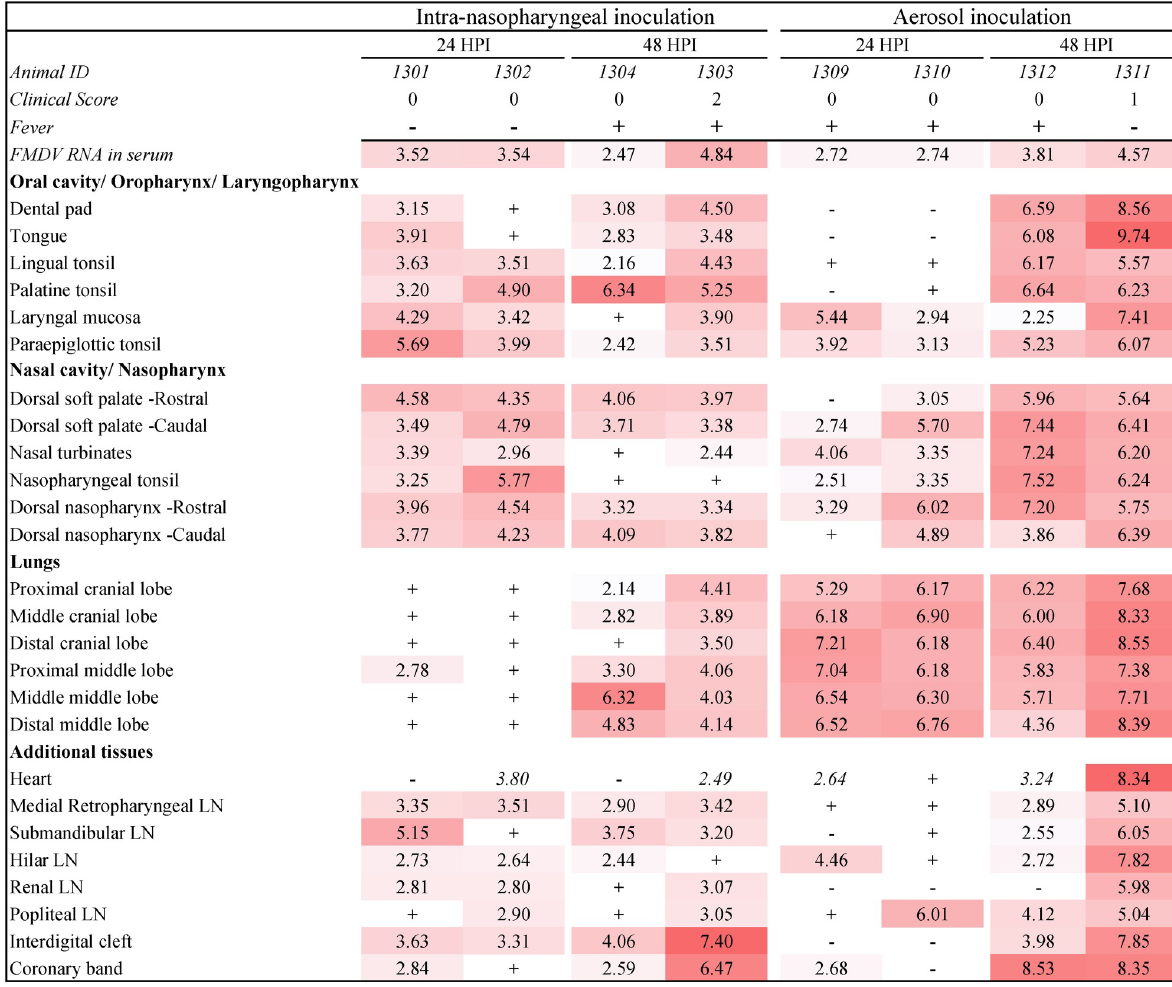
Fig 1. FMDV distribution in ovine tissues during early infection. FMDV detection in tissue samples obtained at 24 and 48 hours post intra- nasopharyngeal or aerosol inoculation. The clinical score represents the numbers of vesicular lesions detected at the time of euthanasia. Numbers in the table represent log 10 genome copy numbers (GCN)/mg of FMDV RNA in tissue or log 10 GCN/ μ l serum. Color gradient indicates increasing FMDV RNA quantities in samples that were positive by both RT-qPCR and virus isolation. Numbers in uncolored cells indicate quantities of FMDV RNA that were detected in samples that were negative by virus isolation, (+) indicates that virus isolation was positive but FMDV RNA content was below the limit of detection ( < 2.0 log 10 GCN/mg), (-) indicates double-negative